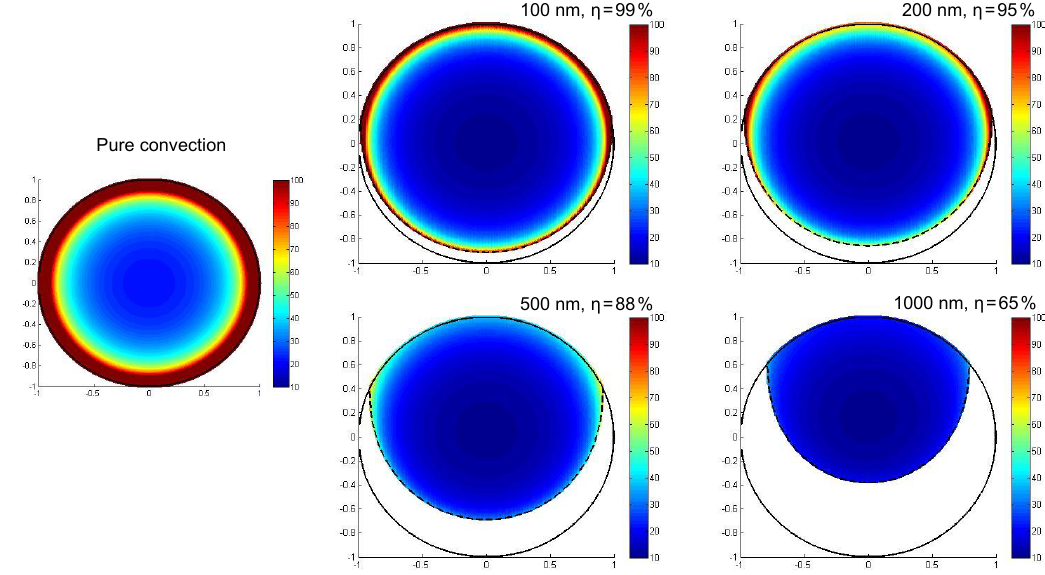
Figure F2. Theoretical residence time distribution (Eq. F4) and penetration efficiency (Eq. F6) of particles with different diameters in a hor- izontal flow tube. Only gravitational settling and convection are considered. The simulation assumes a uniform distribution of monodisperse particles at the entrance of a well-developed laminar flow with no interaction between particles. Each point corresponds to the residence time and the initial position of the particle. The color bar indicates the residence time (min). The open space between the dashed curve and the tube wall indicates the region in which particles have deposited on the tube wall ( η = 0%). The residence time of purely convective, non-diffusing particles (Eq. F7) is shown for